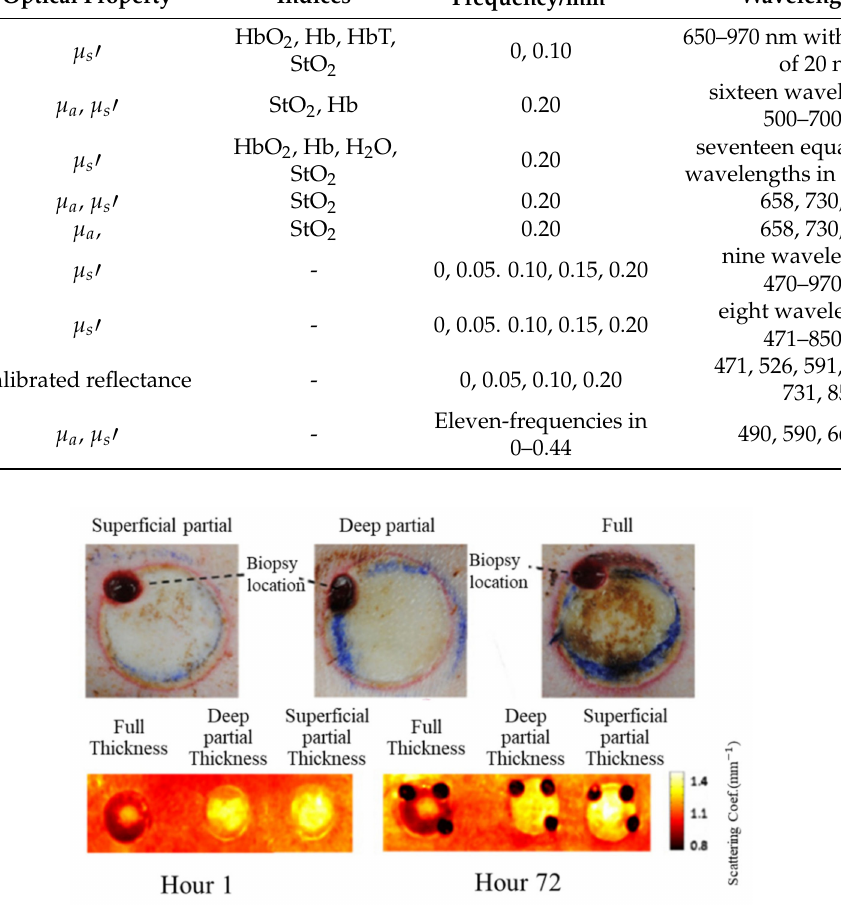
Figure 3. Typical results for burn assessment of porcine dorsal skin in three levels (i.e., superficial partial, deep partial, and full). The top row is for color digital images, and the bottom row is for maps of the reduced scattering coefficients (adapted from Ref.